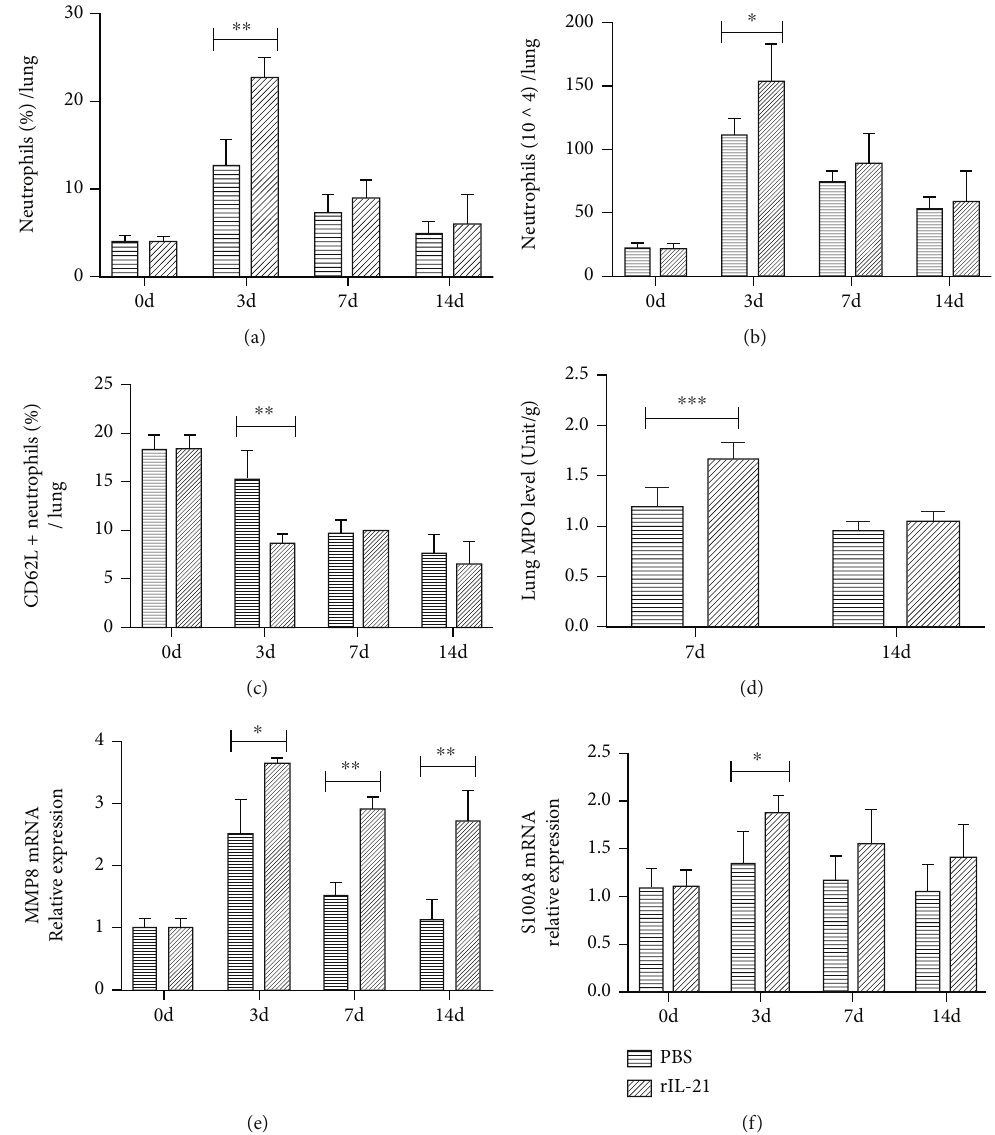
Figure 4: The pulmonary neutrophil level of WT mice after administration of recombinant murine IL-21 (rIL-21) during Chlamydia muridarum ( C. muridarum ) lung infection. For rIL-21 treatment, wild-type (WT) mice were inoculated intranasally with 0.5 μ g rIL-21 in 20 μ l PBS at the day before and days 0, 2, 4, and 6 after C. muridarum infection, and the control group was given 20 μ l sterile PBS in the same schedule. The (a) percentages and (b) numbers of pulmonary neutrophils were detected by fl ow cytometry with pulmonary neutrophils represented as CD45 + CD11b + Ly-6G + cells. (c) The percentages of CD62L positive cells in pulmonary neutrophils were analyzed by fl ow cytometry at indicated times after infection. (d) The myeloperoxidase (MPO) activity in the lung tissues after C. muridarum infection was shown. (e, f) The mRNA level of matrix metalloproteinase 8 (MMP8) and S100A8 was examined by qPCR. Data are represented as means ± SD from n = 3 – 4 per group, representative one of three independent experiments. Statistical signi fi cances of di ff erences are determined by two-way ANOVA followed by Bonferroni ’ s multiple comparisons test. ∗ P < 0 : 05 , ∗∗ P < 0 : 01 , and ∗∗∗ P < 0 : 001